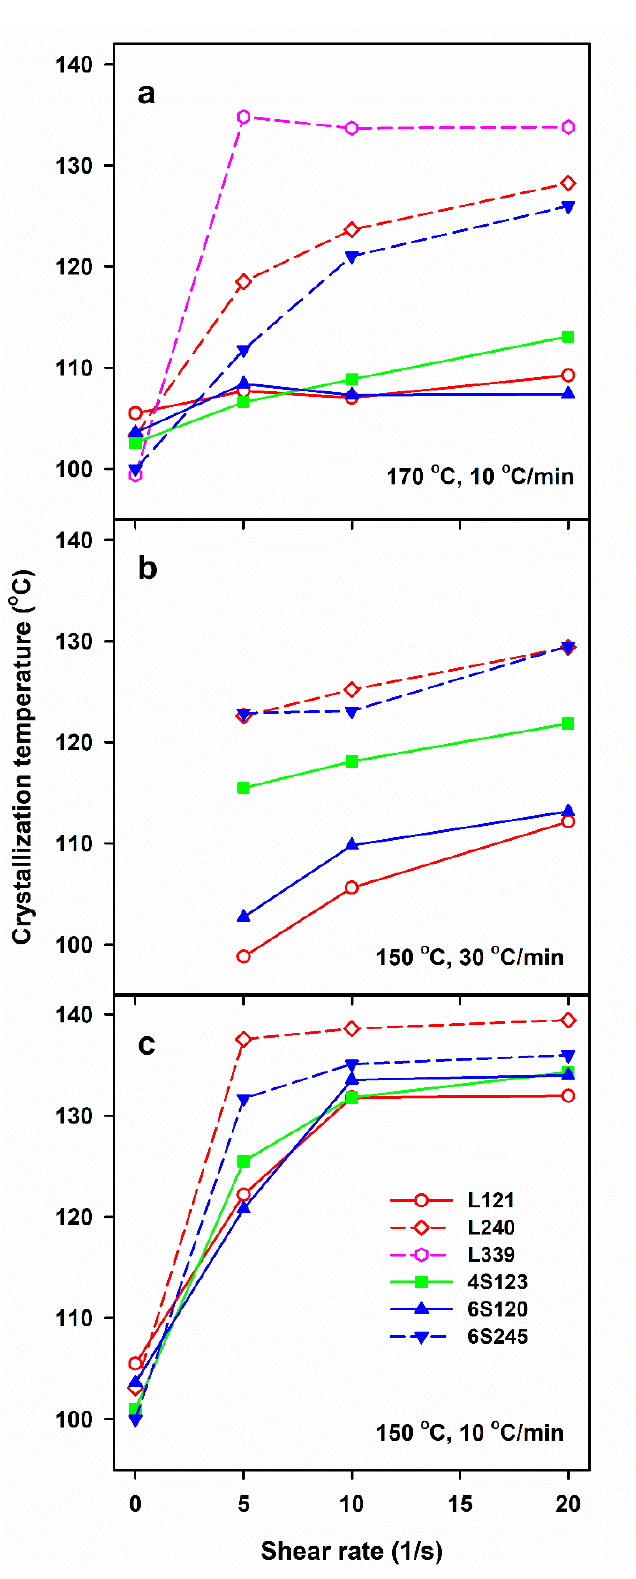
Figure 4. Crystallization peak temperature, T c , during cooling of PLLAs at 10 and 30 °C/min after shearing at 170 C ( a ) and 150 °C ( b , c ) versus shear rate, 𝛾̇ .